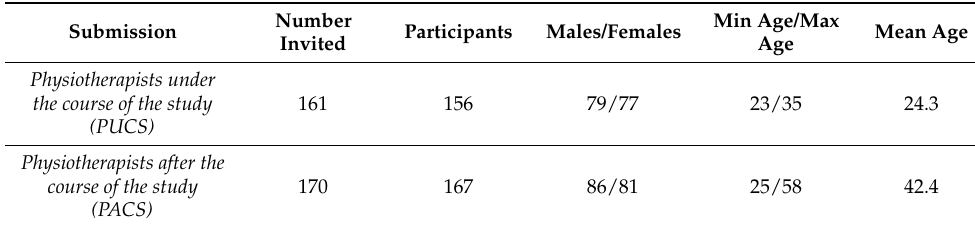
Min Age/Max Mean Age